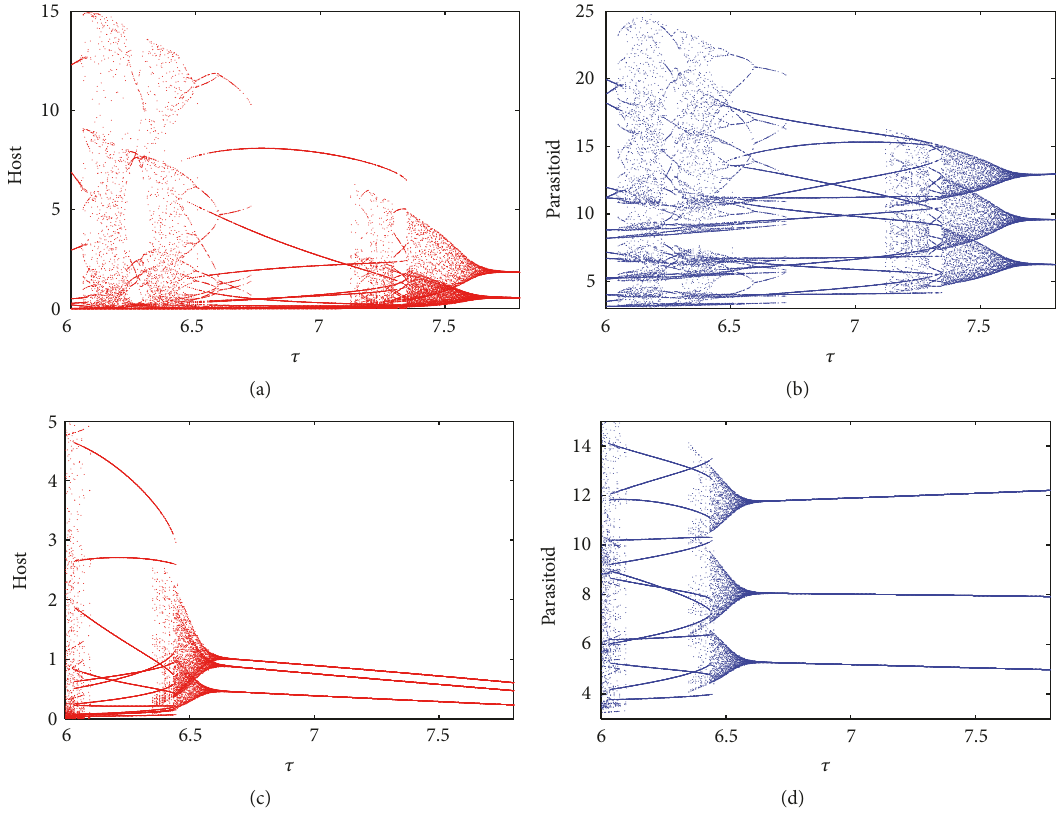
Figure 3: Bifurcation diagram of model (3) with 𝜏 . Here (a) & (b) with 𝜃 1 = 9,𝜃 2 = 2 ; (c) & (d) with 𝜃 1 = 𝜃 2 = 0 , and all other parameters are 𝑎 = 0.39 , 𝑟 = 3.8,𝜎 = 0.6,𝑞 𝑚𝑎𝑥 1 = 0.8 , 𝑞 𝑚𝑎𝑥 2 = 0.3 , 𝑞 = 3 .